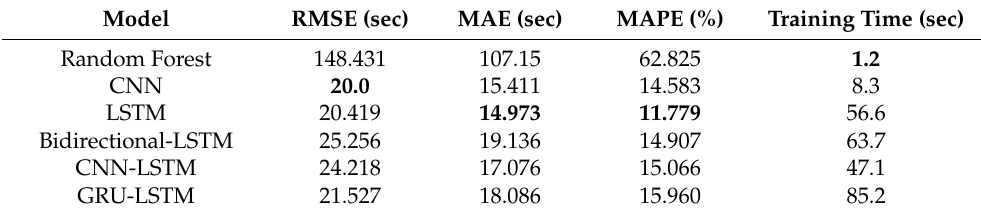
Table 1. Performance on running time prediction.